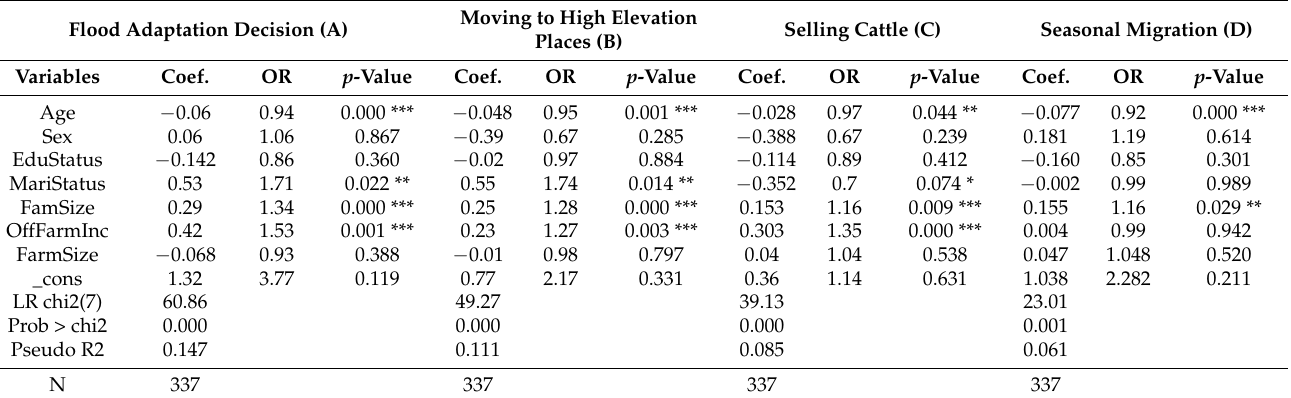
Table 4. Regression Results of the Socioeconomic Model (Short-term coping methods).